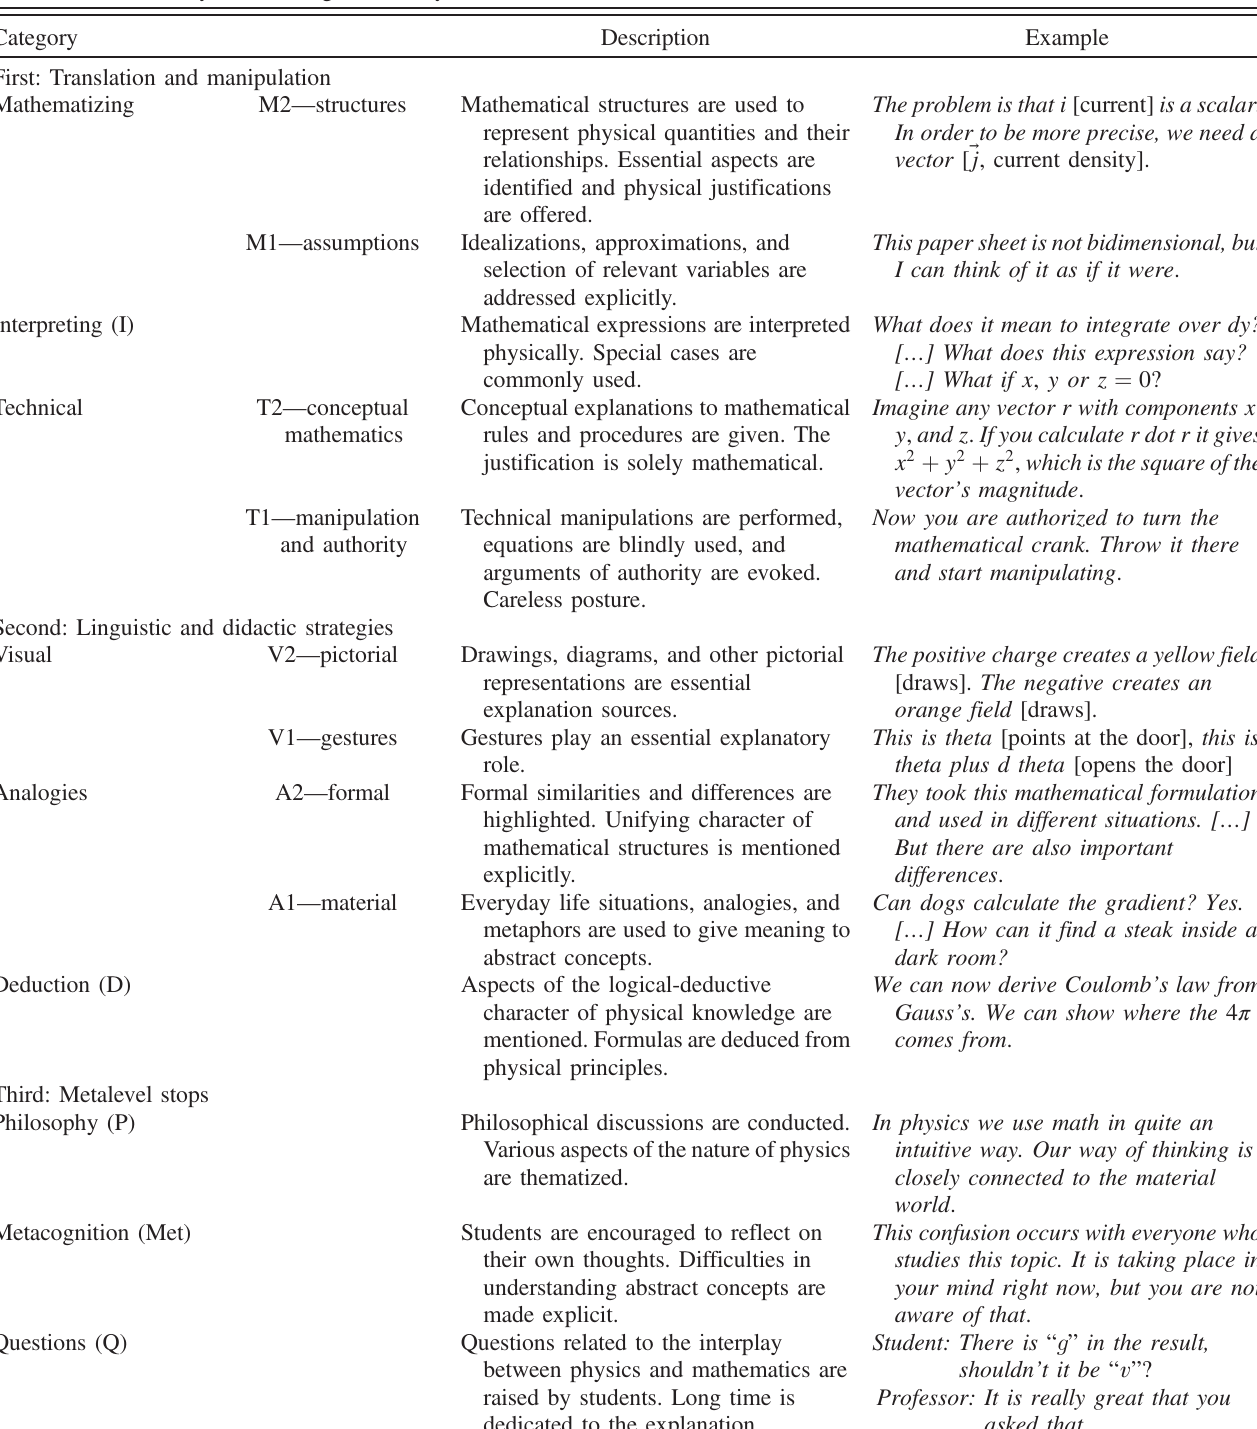
TABLE II. Summary of the categorization